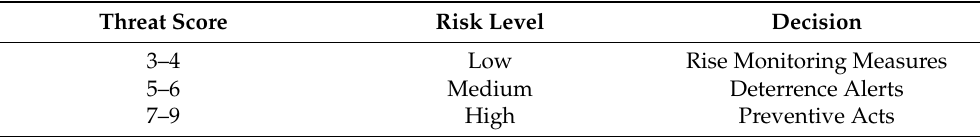
Table 6. The threat score, risk level and decision made.